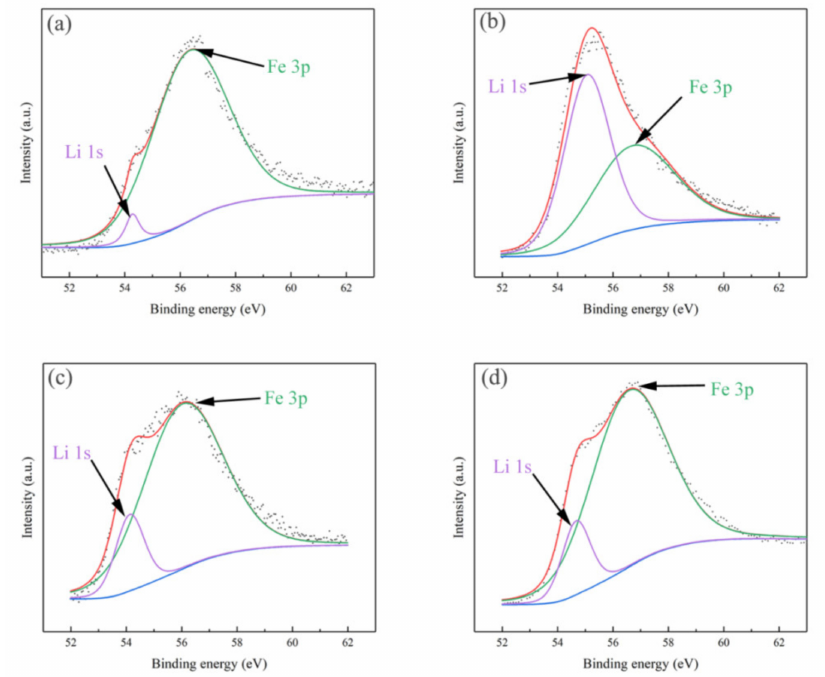
Figure 5. The high-resolution XPS spectra of Fe 3p–Li 1s in different samples: ( a ) LFP-SPS-DC-Top, ( b ) LFP-SPS-DC-Bottom, ( c ) LFP-SPS-AC-Top and ( d ) LFP-SPS-AC-Bottom. Impedance spectroscopy was employed to confirm the Li migration depending on the AC or DC SPS field. Nyquist plots of LiFePO 4 samples are shown in Figure 6. The set of plots reveals a slightly concave semicircular arc and fitted with the equivalent circuit [36] shown inset. The R i component represents the ionic ohmic resistance, and the R e component represents the electronic ohmic resistance. According to the equivalent circuit inserted in Figure 6, the parallel RiRe / Ri + Re is the intersection of the high frequency 1 MHz line and the real axis, and the electronic resistance Re is the intersection of the real axis and1 Hz. The electronic ( σ e ) and ionic ( σ i ) conductivity of the LiFePO 4 samples is calculated after fitting the curves in Figure 6 (listed in Table 1). The ionic conductivity of the DC sample at the top (1.41 × 10 − 4 S/cm) was lower than that at the bottom (2.69 × 10 − 4 S/cm). Instead, the electronic conductivity of the top surface (1.01 × 10 − 5 S/cm) was significantly higher than the bottom (6.84 × 10 − 6 S/cm). This is probably due to the different Li content of the top and bottom samples, which could change σ e [37]. The inductively coupled plasma-optical emission (ICP) results further confirmed that lithium-ion migration occurred during the SPS technique using DC. Oppositely, the respective ionic conductivity (4.42 × 10 − 3 S/cm and 4.71 × 10 − 3 S/cm) and electronic conductivity (2.54 × 10 − 5 S/cm and 2.56 × 10 − 5 S/cm) of LFP-AC are similar in both portions of the specimen as no asymmetric electric field occurred in AC.